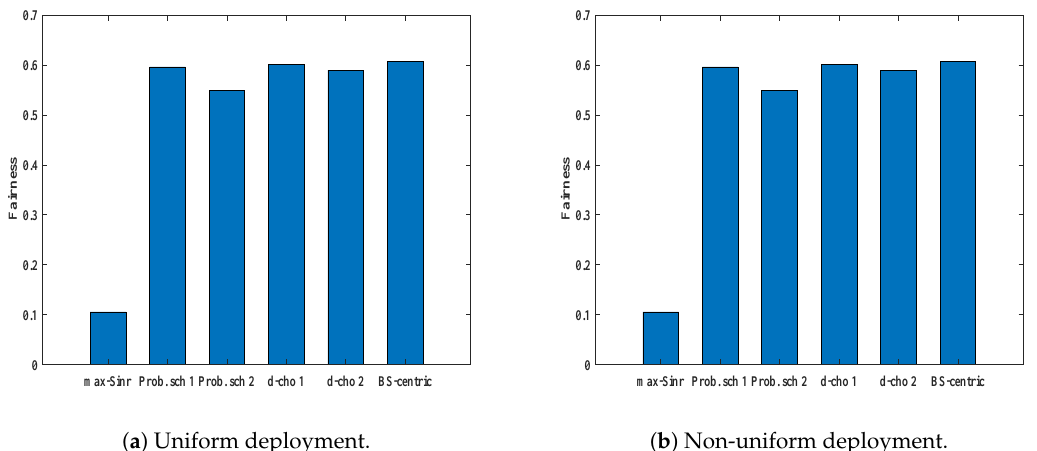
( b ) Non-uniform deployment.